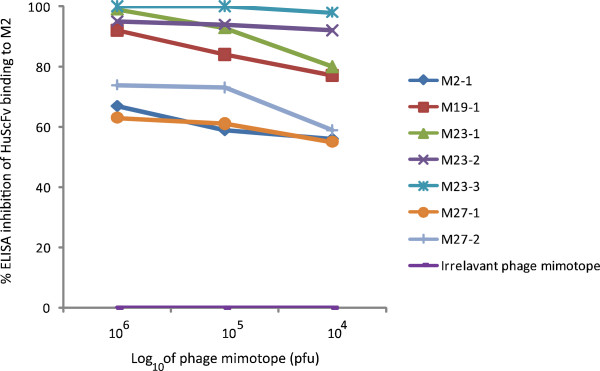
Competitive ELISA for determining efficiencies of phage mimotopes in blocking the HuScFv binding to rM2. In the assay, individual phage mimotope types, i.e., M2-1: ALWPPNLHAWVP, M19-1: VQIPLSYGQYYK, M23-1: HSNWDMPPIRLVAS, M23-2: QYALWPPNQAGVP, and M23-3: HSNWDMPPIRLVAS, M27-1: EDVDEIHNQSHP and M27-2: ALWPPNLHAWVP at 104, 105 and 106 pfu were mixed with individual HuScFv (5 μg) before adding to the ELISA well containing immobilized rM2 (10 μg). HuScFv mixed with irrelevant phage mimotope served as background inhibition controls. The percent ELISA inhibition was calculated. The results indicated that the mimotopes could inhibit the HuScFv binding to rM2; implying that they carried the amino acid residues analogous to the native M2 residues that could be bound by the respective HuScFv.